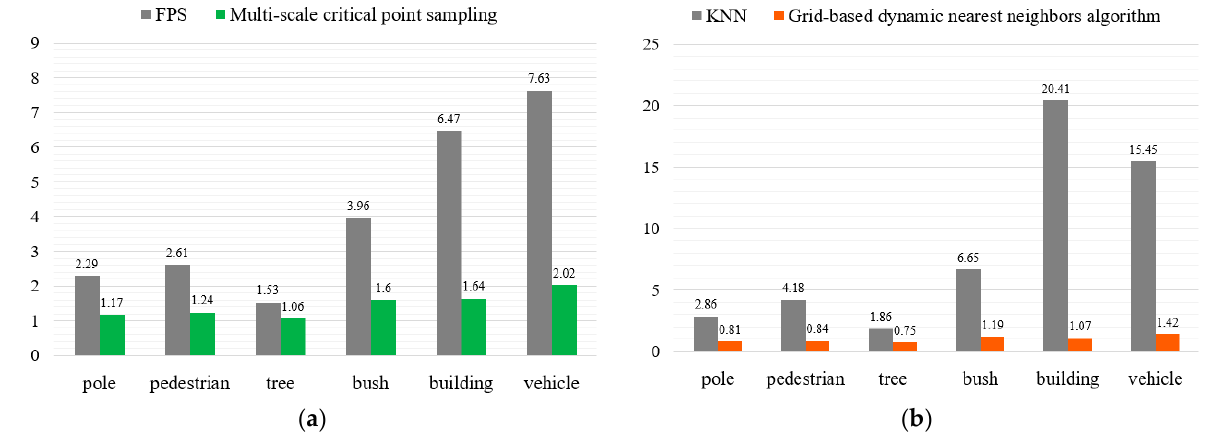
Figure 8. Time consumption comparison of critical points and neighbor points sampling: ( a ) critical points sampling, ( b ) nearest neighbors sampling.